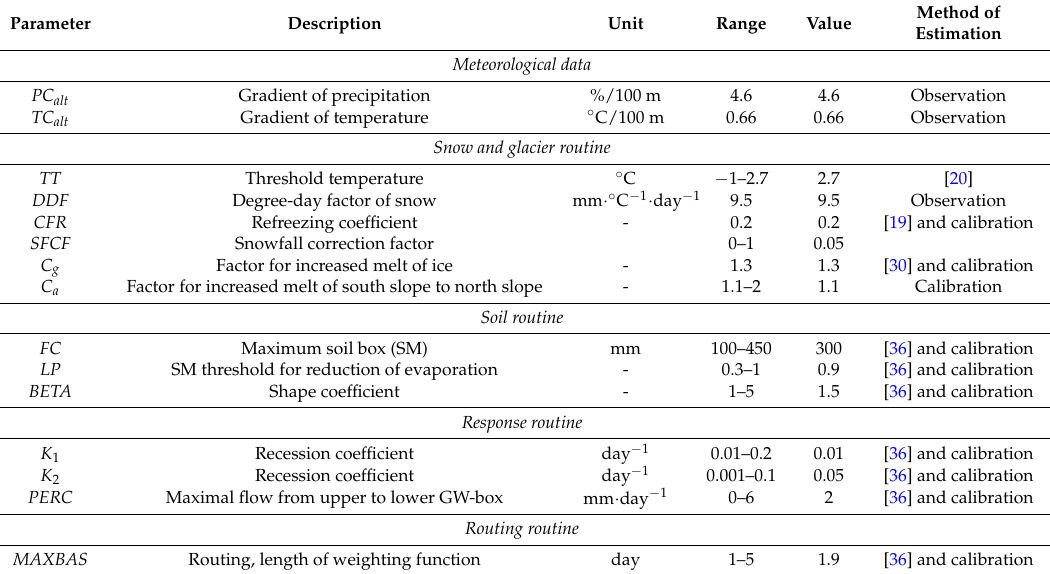
Table 3. Definition of and set of optimized parameters of HBV for the Koxkar River Basin.